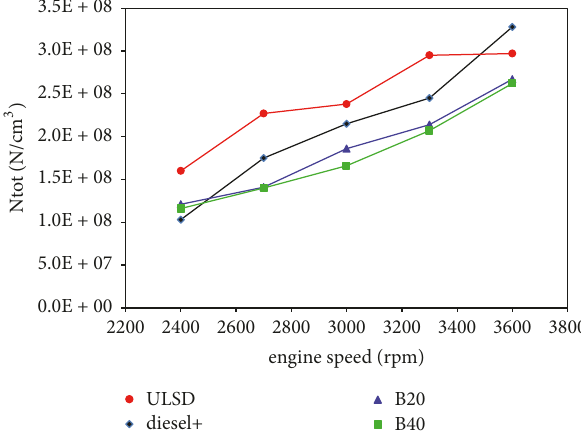
Figure 11: Variation of particle number concentration with engine speed at 80% load.